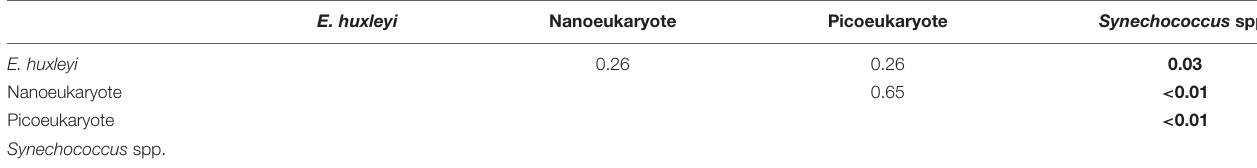
FIGURE 4 | Box plots of the Chesson-Manly index for preferential grazing. The dashed horizontal line is the 0.25 value, which is the line of “neutral grazing preference” (Manly, 1974). Red points are field samples from Mayers et al. (2018). Unfilled data points represent outliers of the data set, values in bold italics are the median values for each phytoplankton group, * symbol indicates significantly different from E. huxleyi. TABLE 3 | p- values from a two-sided Kolmogorov-Smirnov test of Chesson-Manly index values between different phytoplankton